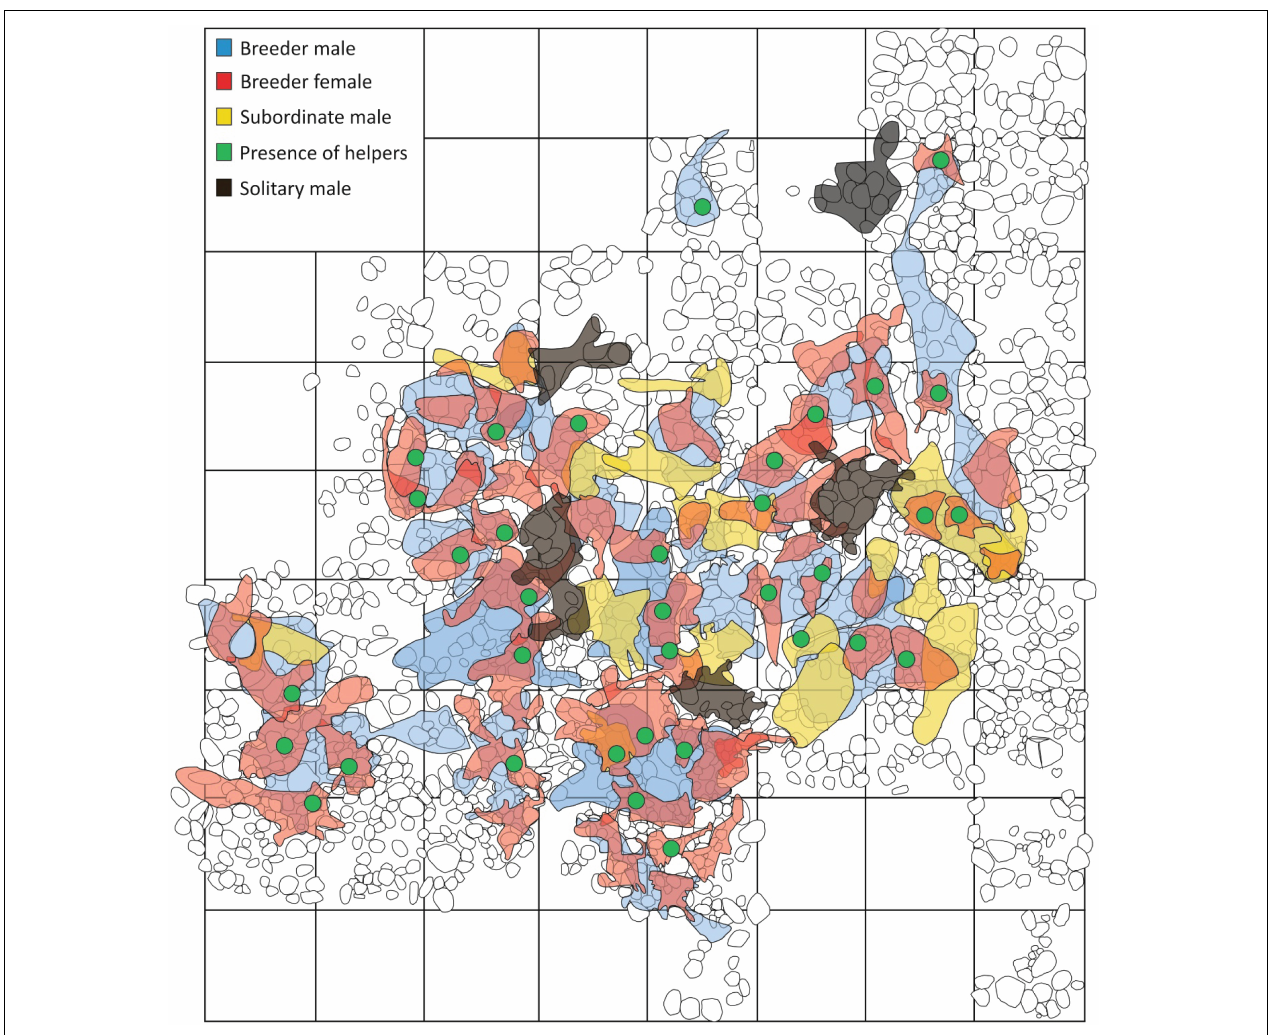
FIGURE 2 | Map of the home ranges of individuals belonging to different social classes of the focal colony in 2016. Different colours indicate different social classes. Green dots indicate helper home ranges, which were small and always within the respective dominant female’s home range. Cobble and rock outlines are by depicted in black lines. Each square measures 1 × 1 m.